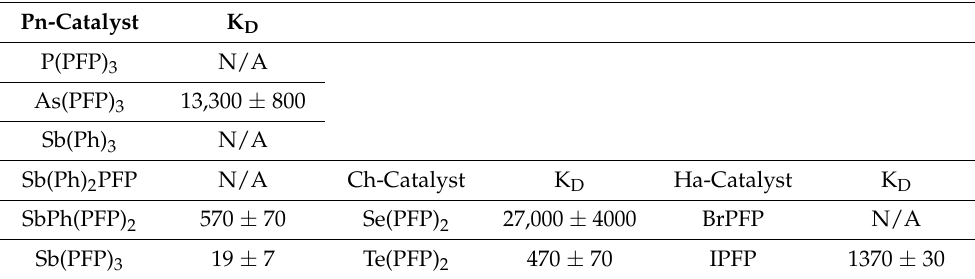
Table 2. Catalyst candidates used and dissociation constants (K D in µ M) of chloride complexes in THF. Ph and PFP stand for phenyl and pentafluorophenyl moieties, respectively.